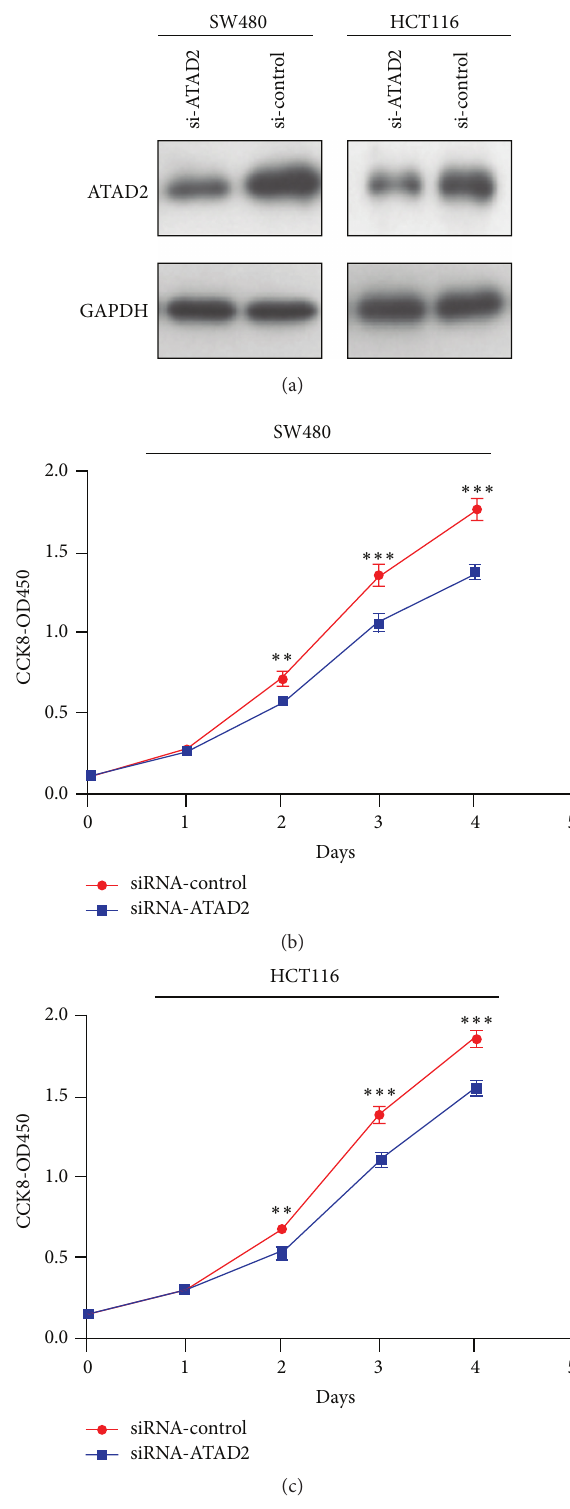
Figure 4: Effect of siRNA-ATAD2 on the proliferation of SW480 and HCT116 cells. (a) ATAD2 knockdown efficiency was confirmed by qPCR in SW480 and HCT116 cells. (b)-(c) siRNA-ATAD2 decreased cell viability measured by CCK8 assays. 𝑃 values were calculated by Student’s 𝑡 -test ( ∗∗ 𝑃 < 0.01 , ∗∗∗ 𝑃 < 0.001 ) and the experiment was repeated at least three